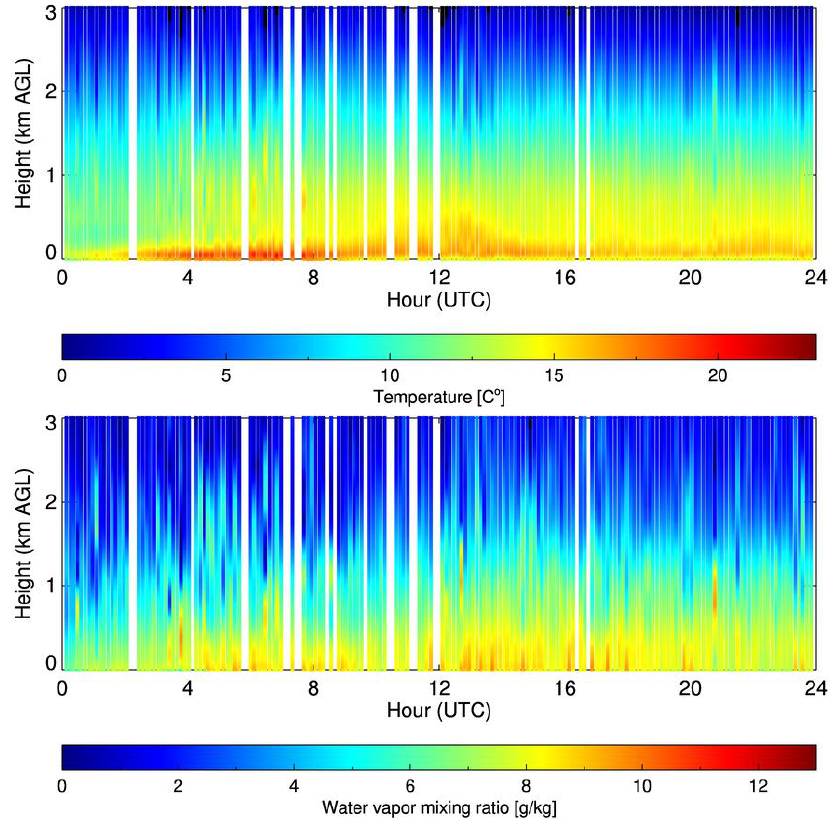
Figure 8. Time series of the retrieved temperature ( top ) and water-vapor mixing ratio ( bottom ) using the TROPoe on 21 October 2010 at AMY (local time = UTC + 9 h).